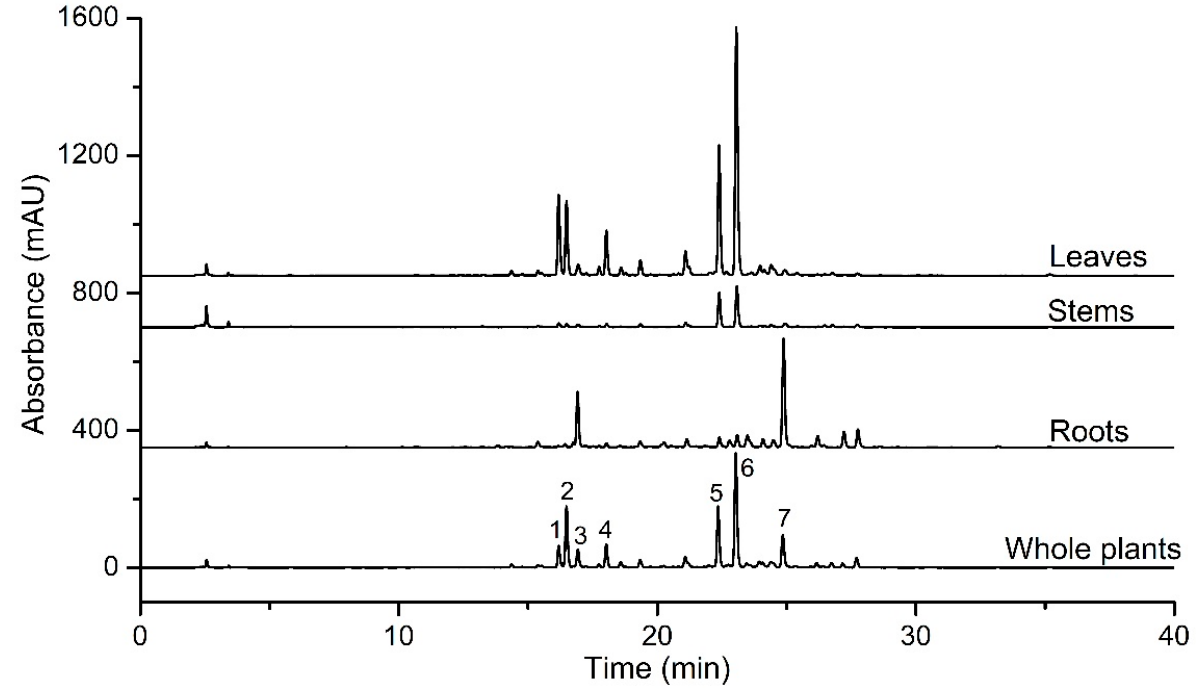
Figure 1. HPLC–UV chromatograms of ethanol extracts from whole plants, roots, stems, and leaves of S. ternatum . Table 2. Identification of the main phytochemicals in S. ternatum using HPLC–ESI-Q-TOF-MS/MS.